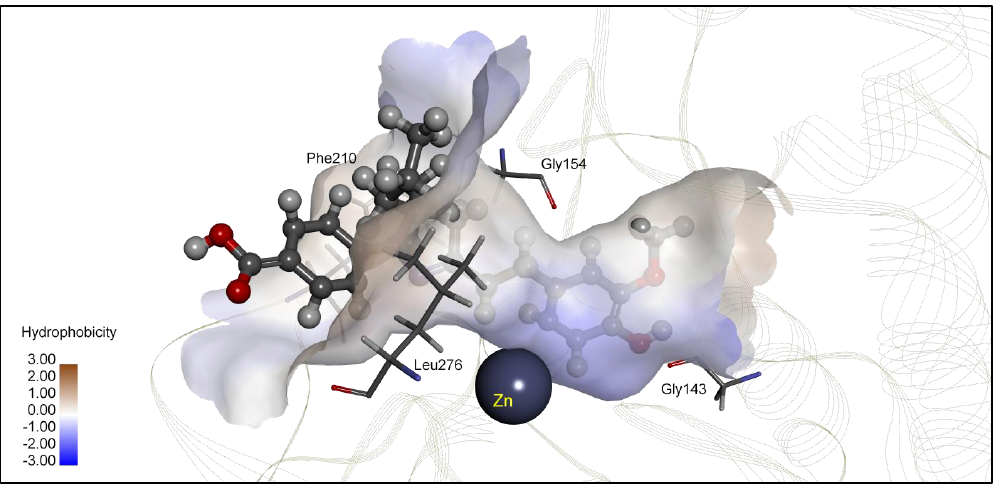
Figure 4. The interaction mode of 5k in the active site of HDAC2.